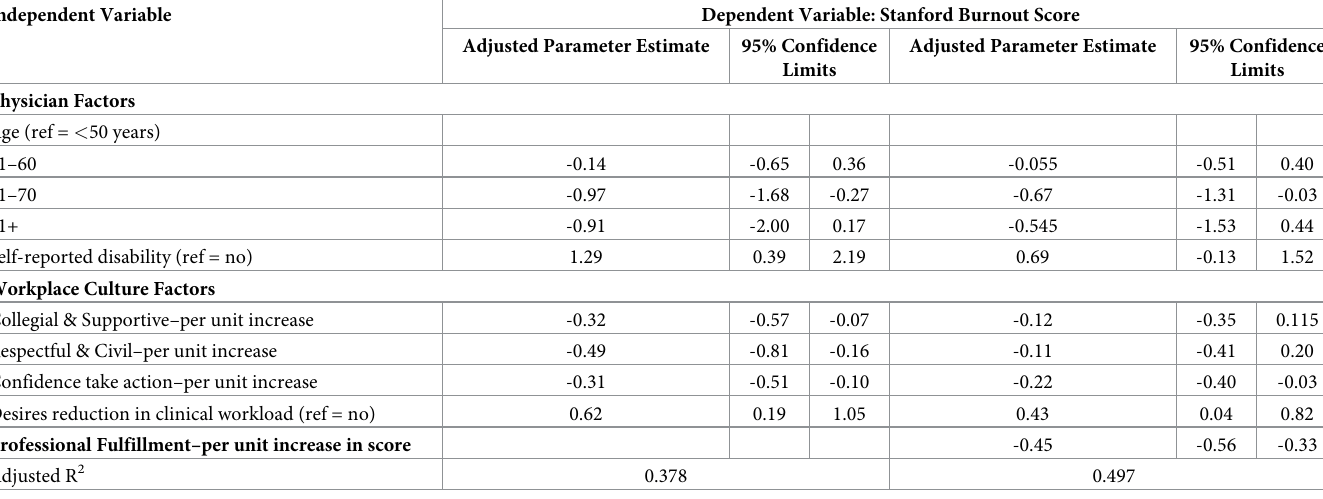
Table 5. Correlates of burnout–professional fulfillment added to the multivariable model a